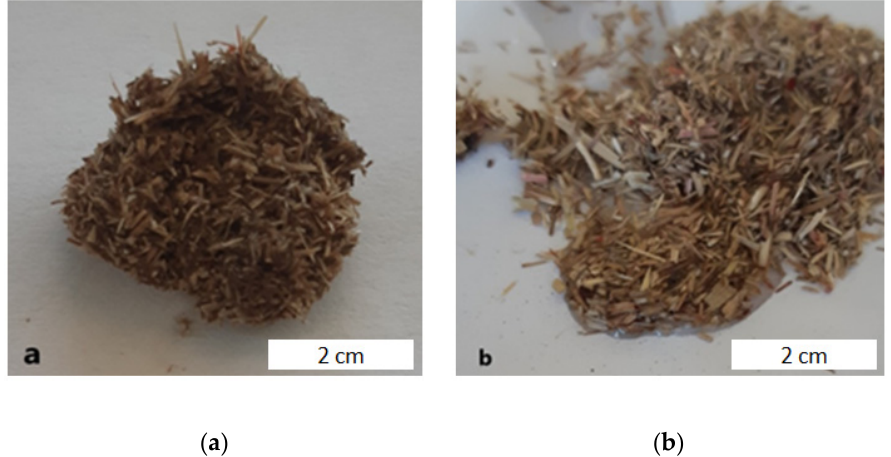
Figure 7. Green pellet of Miscanthus sinensis ( a ); Green pellet of Lavandula angustifolia ( b ).